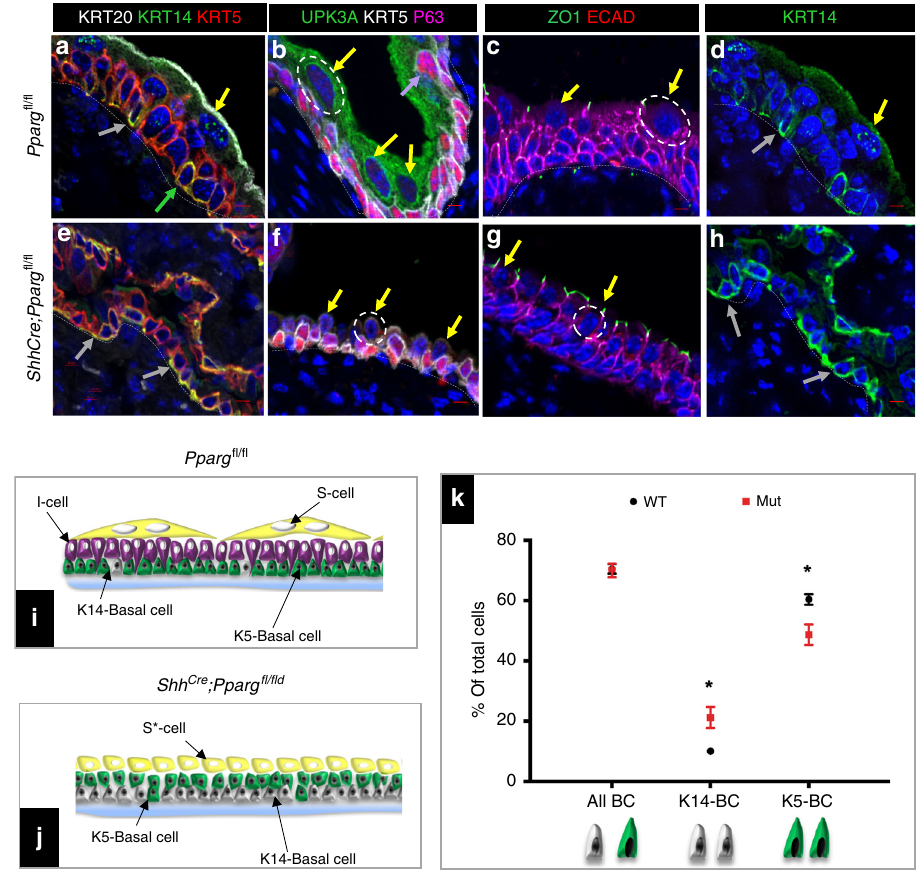
Fig. 2 Urothelial abnormalities in adult Shh Cre ;Pparg fl / fl mutants. a , e Expression of Krt20, Krt14, and Krt5 in an adult Pparg fl / fl control mouse ( a ) and in a Shh Cre ;Pparg fl / fl mutant ( e ). b , f Expression of Upk3a, Krt5, and p63 in a Pparg fl / fl control mouse ( b ) and in a Shh Cre ;Pparg fl / fl mutant ( f ). c , g )Expression of ZO1 and E-cadherin in a Pparg fl / fl control mouse ( c ) and in a Shh Cre ;Pparg fl / fl mutant ( g ). d , h Krt14 expression in a Pparg fl / fl control ( d ) and in a Shh Cre ; Pparg fl / fl mutant ( h ). Gray arrows denote abnormal S cells; yellow arrows denote S cells; purple arrows denote I cells; and green arrows denote basal cells. i , j A schematic representation showing cell types in the adult urothelium of a Pparg fl / fl control mouse ( i ) and in a Shh Cre ;Pparg fl / fl mutant ( j ). k Quanti fi cation of numbers of Krt14 and Krt5 expressing basal cells in the urothelium of adult Pparg fl / fl control mice and Shh Cre ;Pparg fl / fl mutants. Signi fi cance calculated by a two-tailed Student ’ s t test; * p < 0.05. Numbers are means of percentages ± SEM. Scale bar: 50 μ m. The number of animals used in this experiment was: adult mutant, n = 9; adult control, n = 6. Source data are provided as a Source Data fi